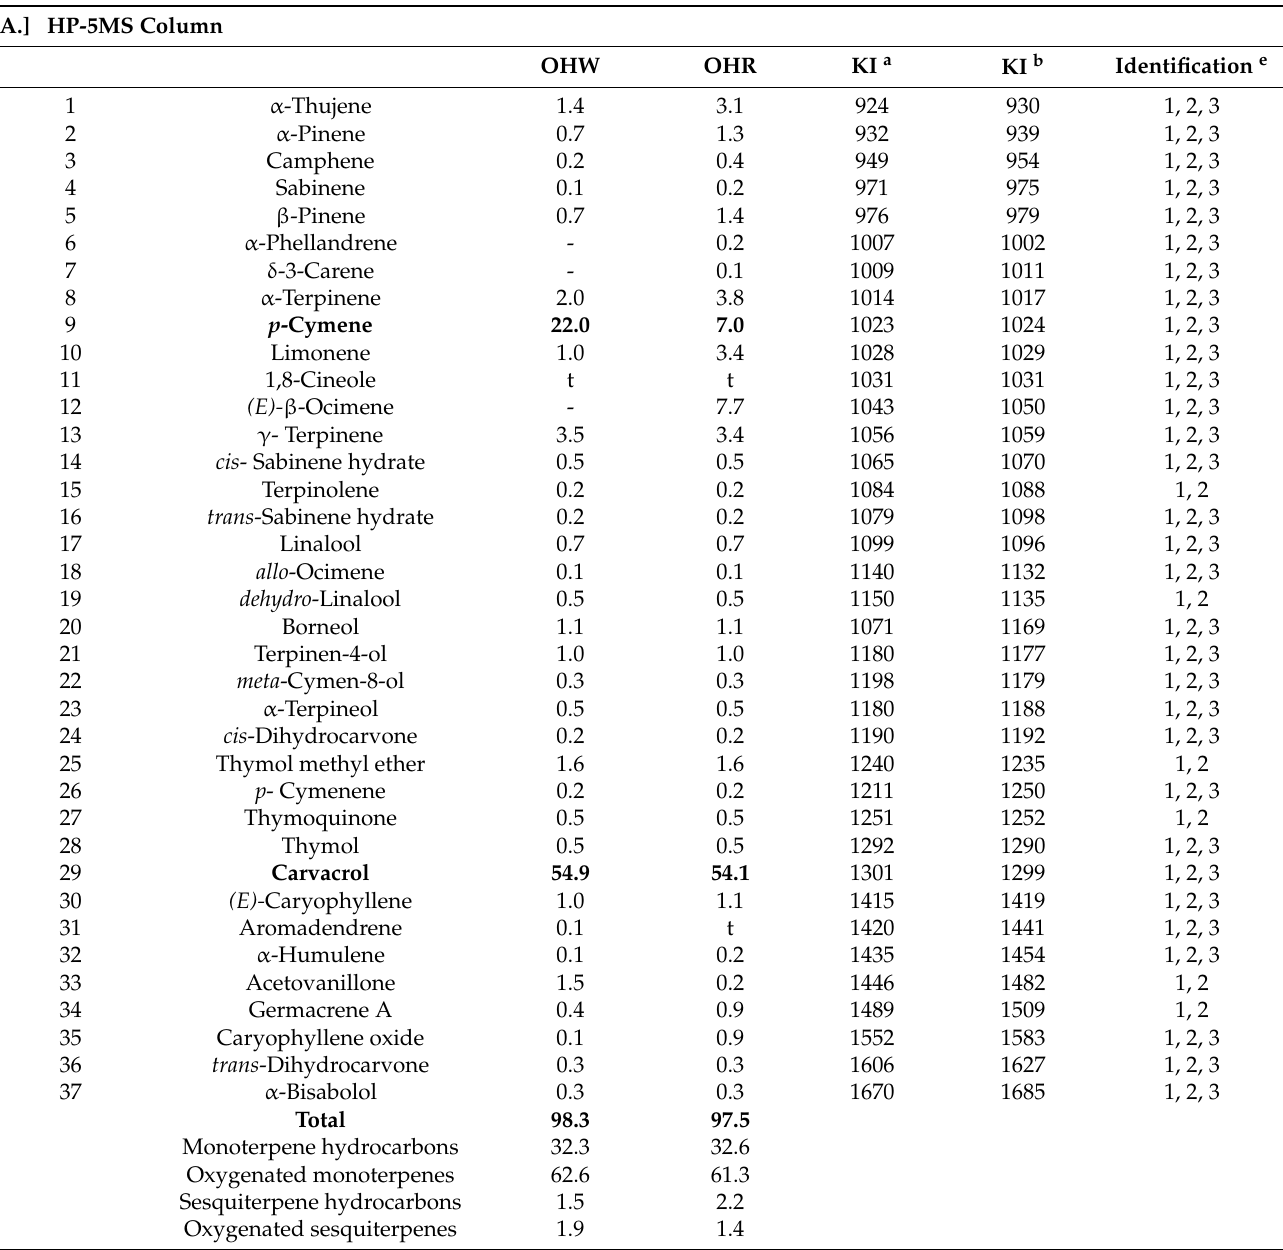
Table 1. Chemical composition of the EOs of OHW and